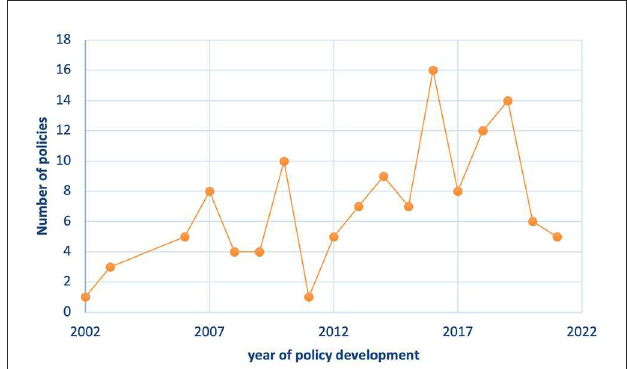
FIGURE2 Distribution of the number of university RI policies.